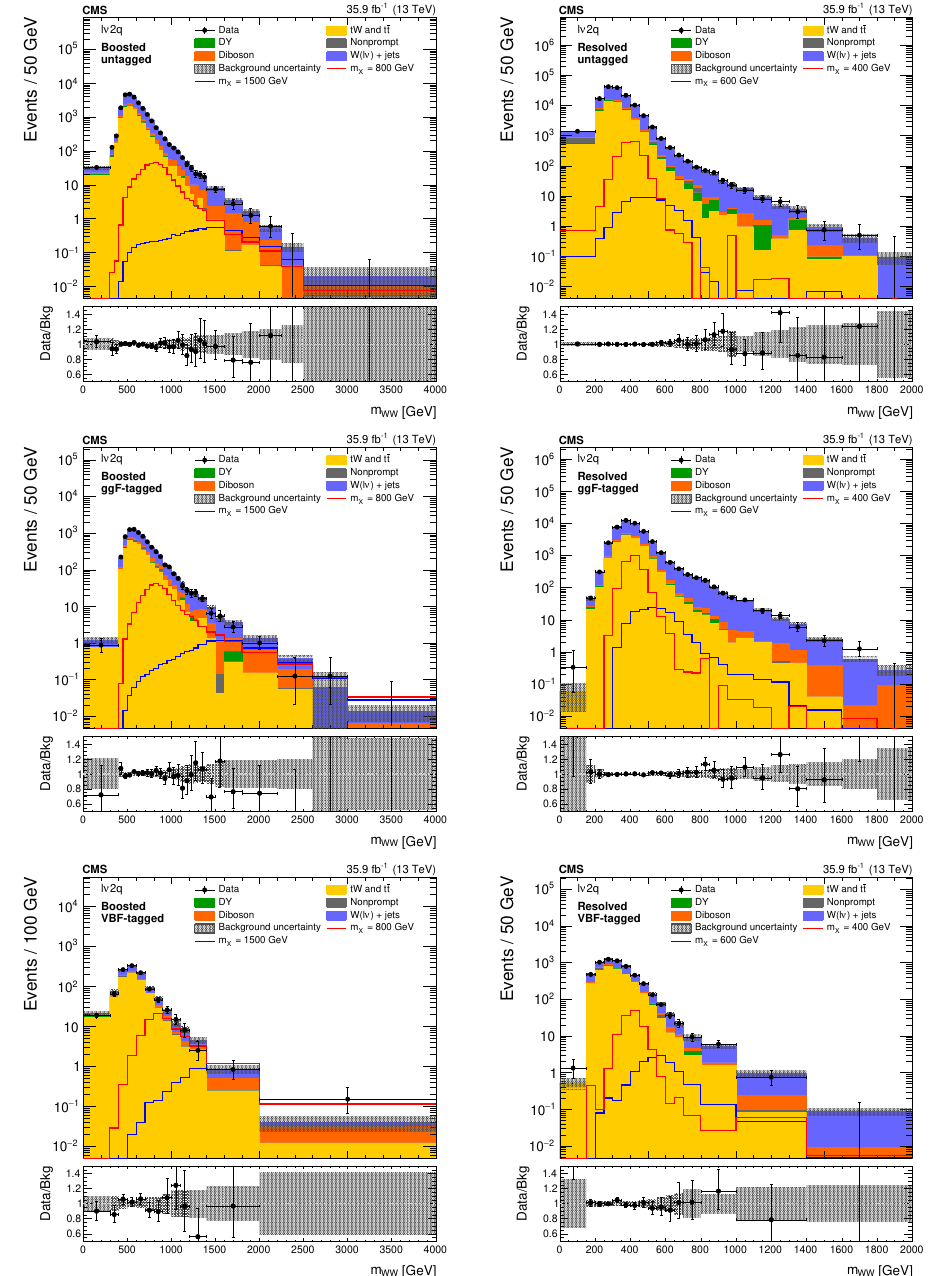
Figure 3 . The m distributions in the ‘(cid:23) 2q boosted (left) and resolved (right) categories, after WW performing a background-only (cid:12)t with the dominant background normalizations determined using control regions. Electron and muon channels are combined. The points represent the data and the stacked histograms the expected backgrounds. Also shown are the sum of the expected ggF- and VBF-produced signals for m = 800 and 1500 GeV (left), and m = 400 and 600 GeV (right), X X normalized to the SM cross sections, and without considering interference e(cid:11)ects. The hatched area shows the combined statistical and systematic uncertainties in the background estimation. Lower panels show the ratio of data to expected background. Larger bin widths are used at higher m ; WW the bin widths are indicated by the horizontal error bars.